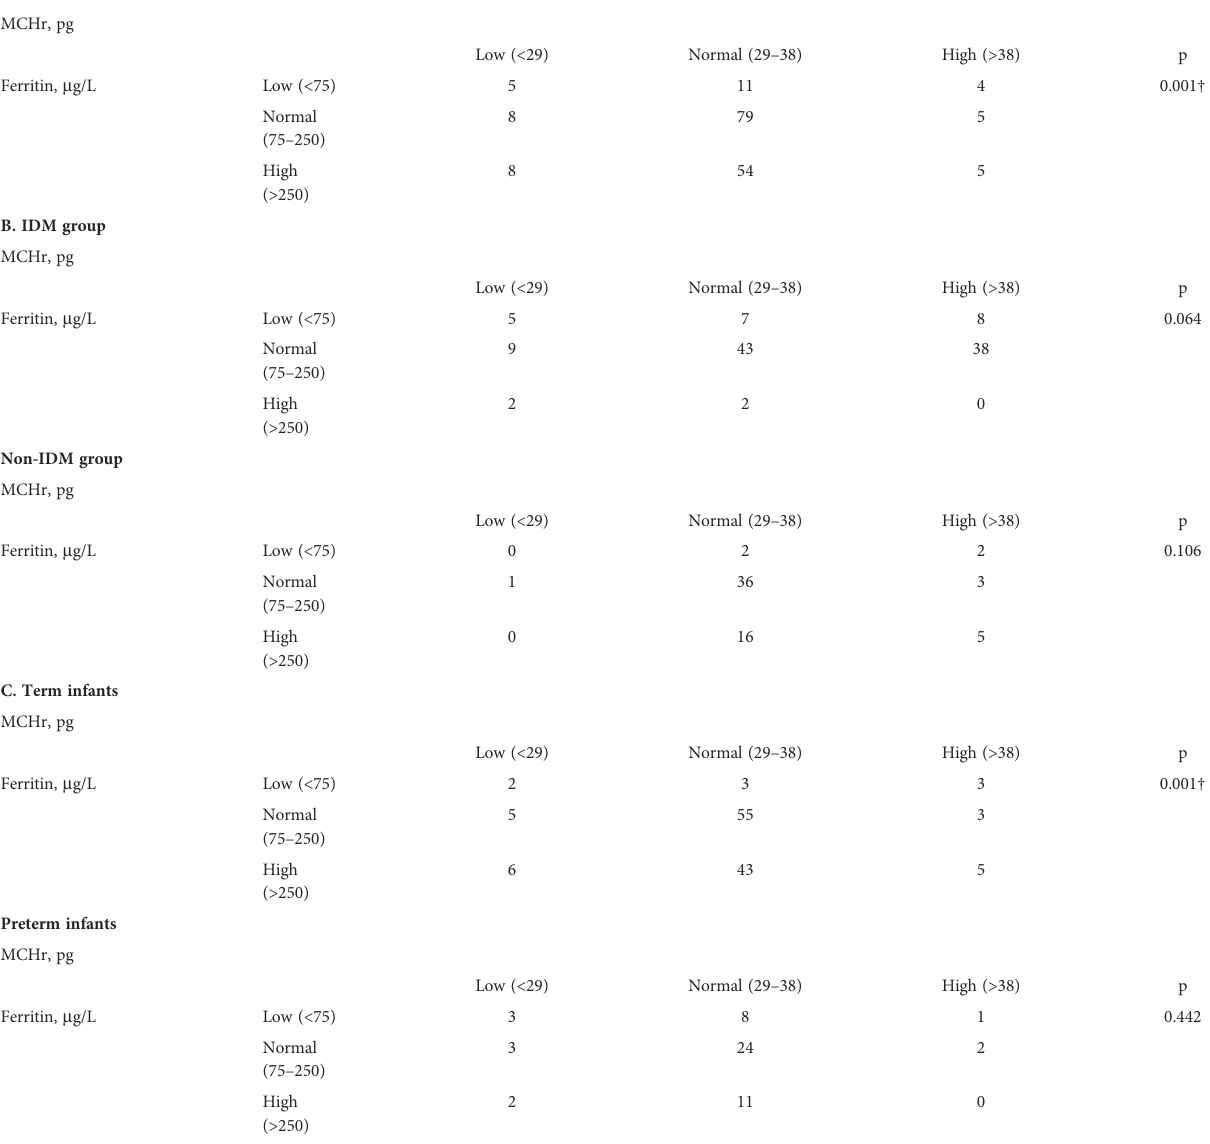
TABLE 4 Discordance between neonatal MCHr and ferritin, with a subgroup analysis in IDM group and non-IDM group, and term and preterm